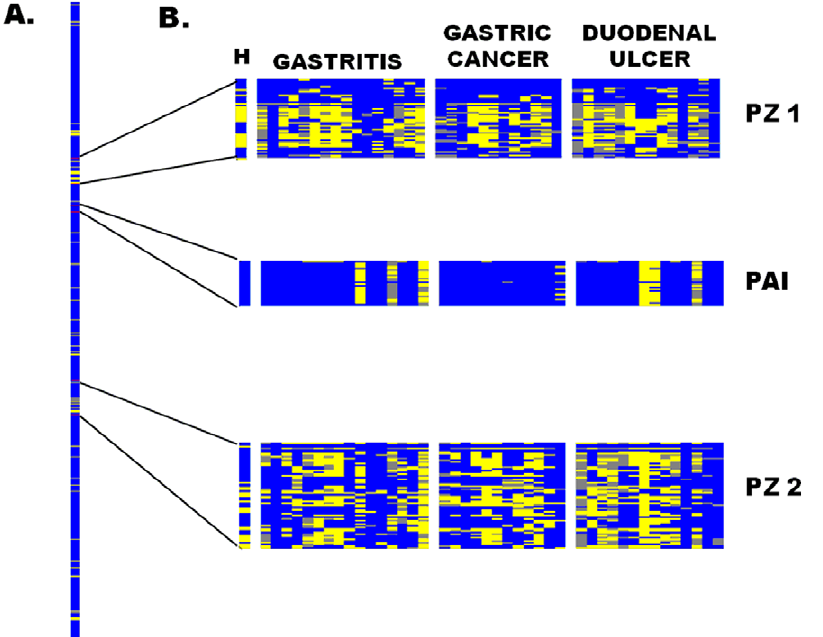
Figure 6. Genomic comparison of the Huichol H.pylori 368H strain with strains from Mexican-Mestizo population using whole- genome microarrays. A). Representation of the entire H. pylori chromosome of the 368H strain, ordered combining the maps of strains 26695 and J99. The scanogram indicates genes present (blue) or absent (yellow) and missing data (gray). B). The plasticity zones PZ1, PZ2 and cagPAI are compared with that of patients with gastritis, gastrtic cancer and duodenal ulcer. Variability in the gene content of these zones was significantly lower in the Huichol strain.